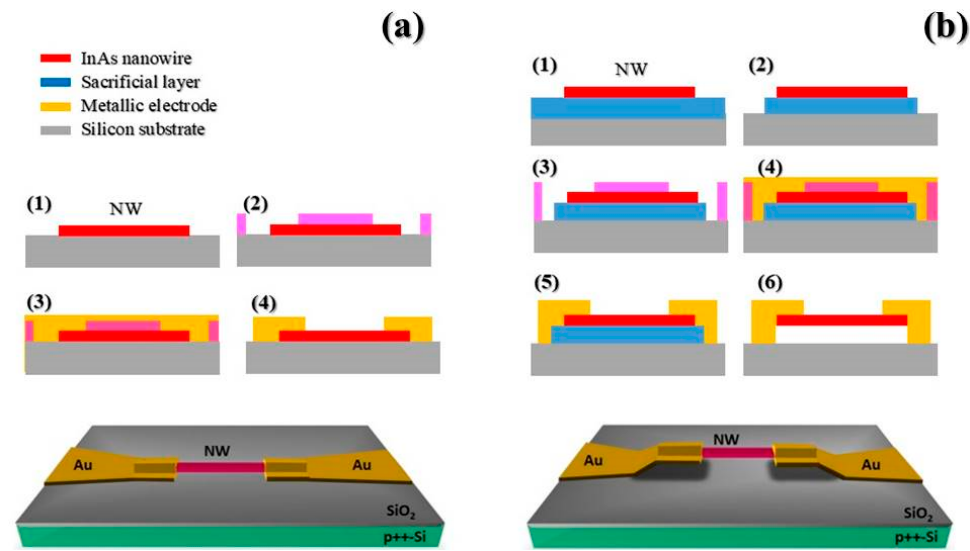
Figure 1. Fabrication protocol for ( a ) supported and ( b ) suspended nanowire-based devices. In the upper part of Figure ( a ) and ( b ), a schematic representation of the fabrication sequence for the two types of devices is depicted. The bottom part shows a schematic representation of the device architectures. The fabrication process for the supported device ( a ) consists of: (1) NW (nanowire) deposition by drop casting, (2) Electron beam lithography (EBL) patterning, (3) metal contact thermal evaporation, (4) Lift-off. The fabrication process of the suspended nanowire device ( b ) includes two additional steps at the beginning of the process, which are the deposition and patterning of a sacrificial layer in the region underneath the nanowire (steps (1) and (2)). The steps (3), (4), (5) coincide with steps (2), (3), and (4) of the case (a). Step (6) consists of the removal of the sacrificial layer by means of O 2 plasma, leaving the NW suspended at a distance of approximately 250 nm from the substrate.